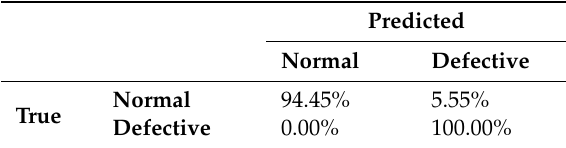
Table 3. Confusion matrix averaged over the 10 random